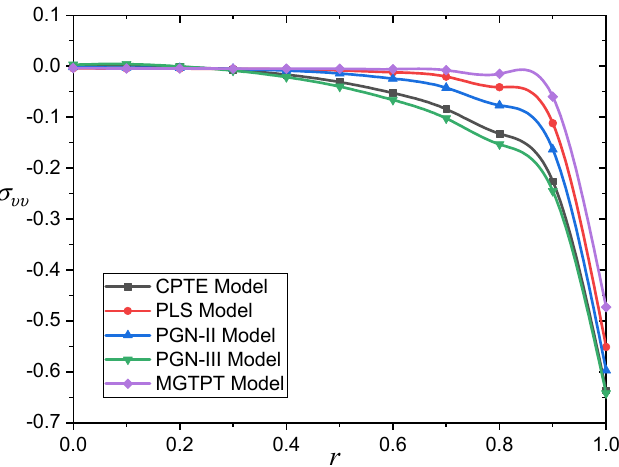
Figure 5. The hoop stress variation (cid:2026) (cid:3107)(cid:3107) under different photothermal models. Figure 6 and Table 6 demonstrate the Maxwell’s stress (cid:2028) (cid:3045)(cid:3045) fluctuation vs. (cid:1870) over a wide range of 0 < (cid:1870) ≤ 1 for different models of photo-thermoelasticity. The speed of propagation of electromagnetic waves is limited and corresponds to the physical behavior of photo-thermal materials. We also note that the behavior of the curves is the same and that there are small differences between the different models.